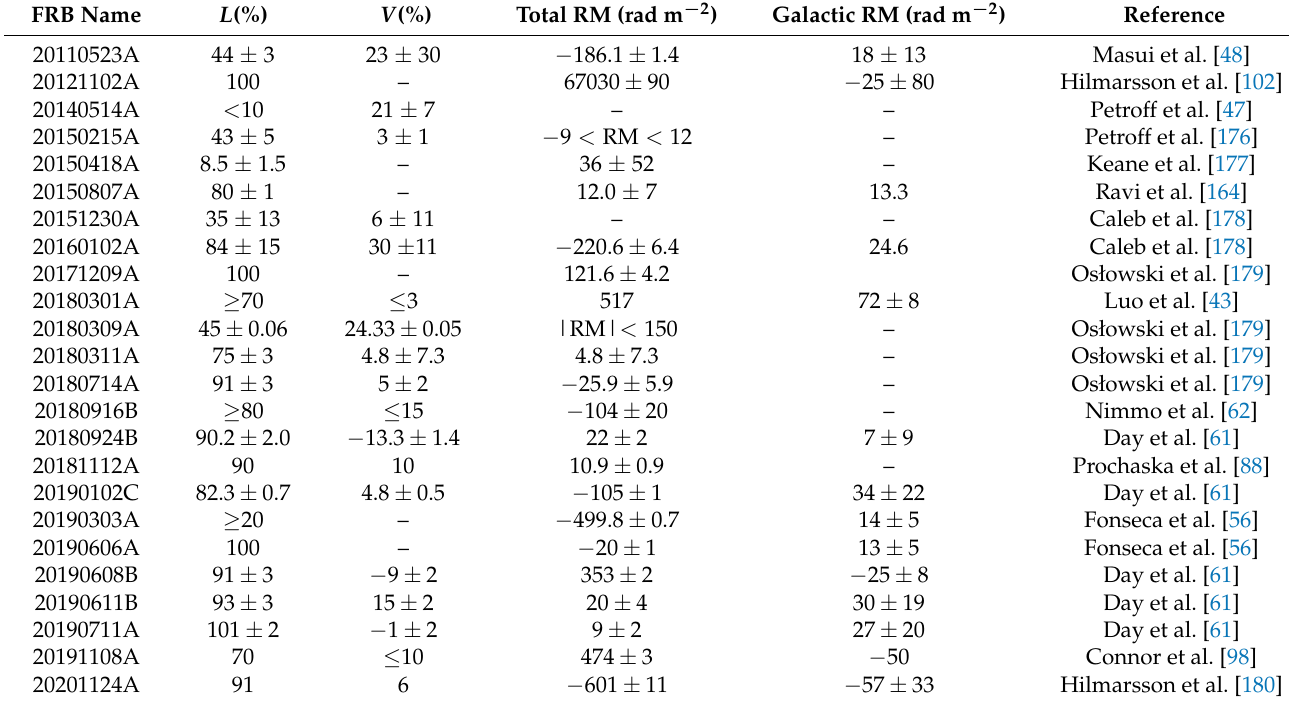
Table 2. Summary of the polarization properties measured in the FRB sample available so far. The second and third columns list the observed fractional linear and circular polarization,